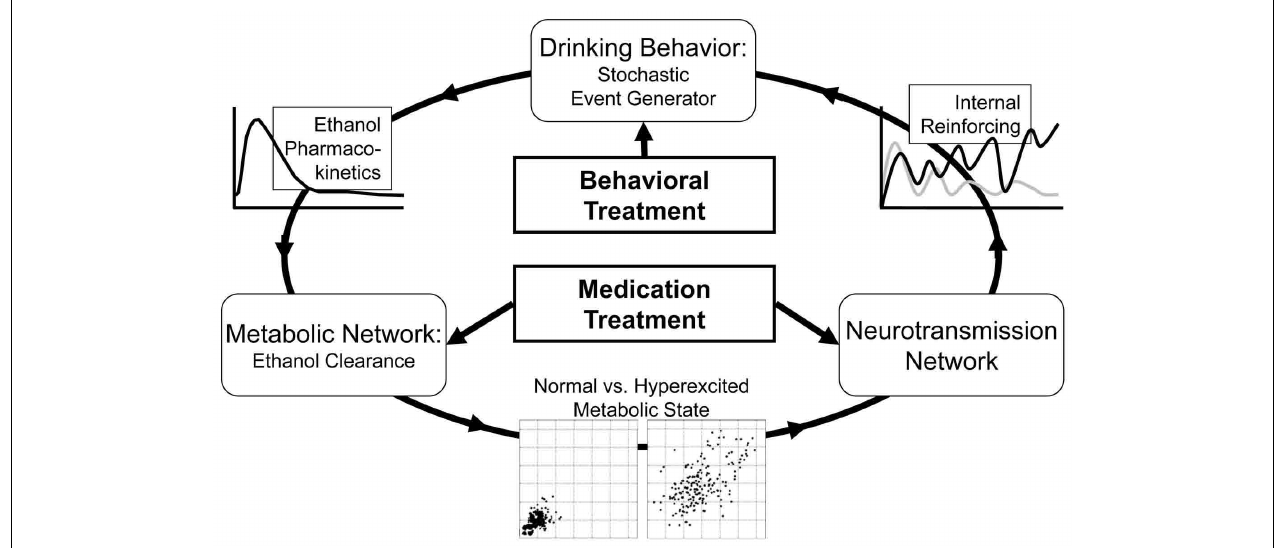
FIGURE 1 | Recurrent bio-behavioral process of alcohol dependence and